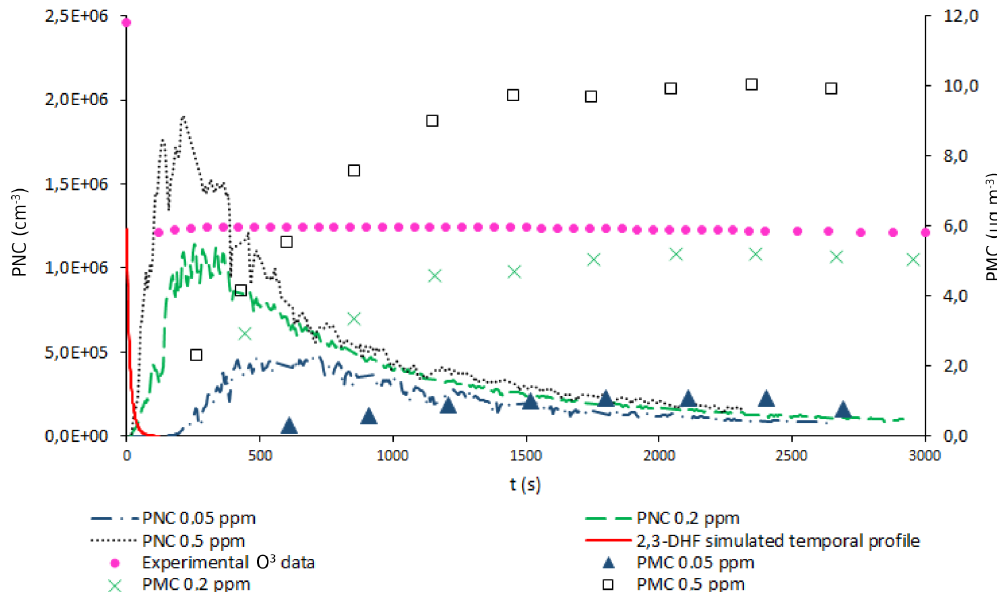
Figure 3. PNC and PMC profiles for different SO 2 initial concentrations (0.05, 0.2 and 0.5ppm). This series of experiments was carried out under dry conditions and with 0.5ppm of 2,3-DHF and 1ppm of ozone initial concentrations. Simulated temporal profile of 2,3-DHF, red solid line.